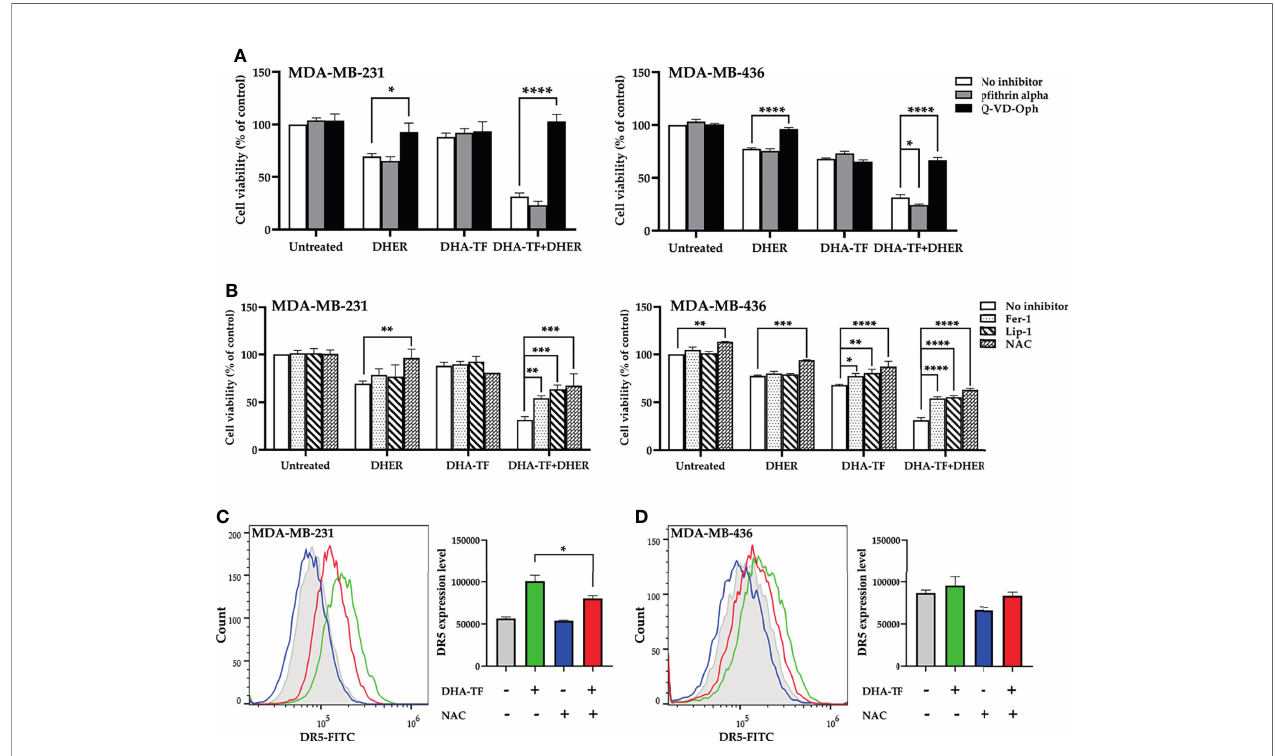
FIGURE 8 | Caspase inhibitor and ROS inhibitor rescue cells from DHA-TF combined DHER-induced cell death. (A) Cells were pretreated with/without 20 µM p fi thrin alpha or 10 µM Q-VD-Oph for 2 h, followed with 15 µM DHA-TF and/or 5 ng/mL DHER. (B) Instead of p fi thrin alpha and Q-VD-Oph, the cells were pretreated with 10 µM ferrostatin-1, 2 µM liproxstatin-1, or 5 mM N-Acetyl-L-cysteine. Cell viability was determined by MTS assay. NAC decreases DR5 expression in DHA-TF treated MDA-MB-231 (C) and MDA-MB-436 (D) cells. The geometric mean of DR5 expression relative to isotype is analyzed using FlowJo v10 software and shown in bar graphs. Data shown are mean ± SEM from three independent experiments. *0.01 < p ≤ 0.05, **0.001 < p ≤ 0.01, ***0.0001 < p ≤ 0.001, ****p ≤